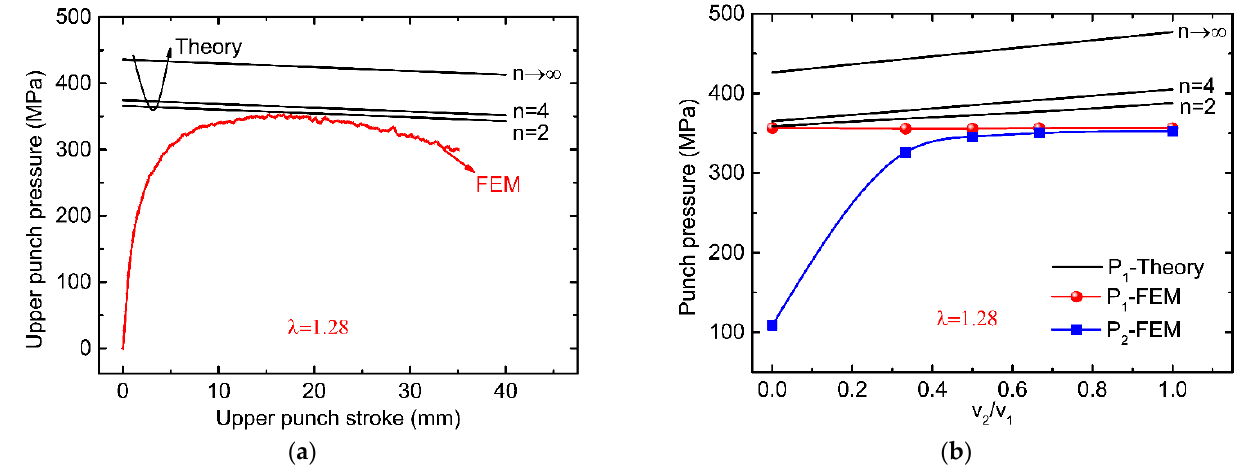
Figure 7. Extrusion pressure P 1 of the upper ram obtained from theory at different n values, and comparison of those extracted from FEM: ( a ) P 1 vs. stroke at v 2 / v 1 = 0, λ = 1.28 and ( b ) P 1 vs. velocity ratio at v 2 / v 1 = 0~1 and λ = 1.28.